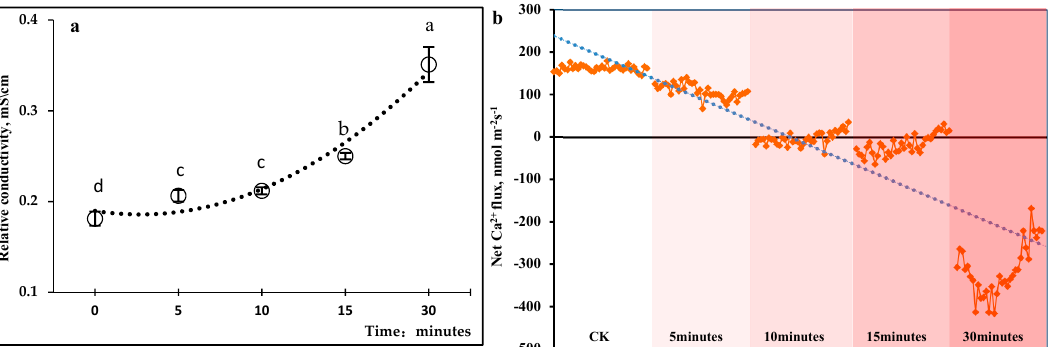
Figure 4. Ca 2+ flux of the pileorhiza cells of P. edulis seedlings under different durations of PEG-treatment. ( a ) The relative conductivity of leaves from P. edulis seedlings treated with PEG-simulated drought stress for 5 min, 10 min, 15 min, and 30 min (Data Repetition: 6 replicates). The control (CK) is represented by 0, which was a control group incubated with distilled water. The dashed curve ( y = 0.0132 x 2 − 0.0406 x + 0.2171, R 2 = 0.9615) represents the linear regression model for relative conductivity and PEG-simulated drought stress. ( b ) The depth of the red color represents the length of treatment time with 20% PEG simulating drought stress. From left to right in Figure 4b: the CK group, PEG-simulated drought stress treatment for 5 min, 10 min, 15 min, and 30 min, respectively. The flux data for each treatment in the figures reflected the steady-state real-time flux of maximum response to Ca 2+ under drought stress (Data Repetition: 3 replicates); each segment of real-time data comprises flux data for three minutes.